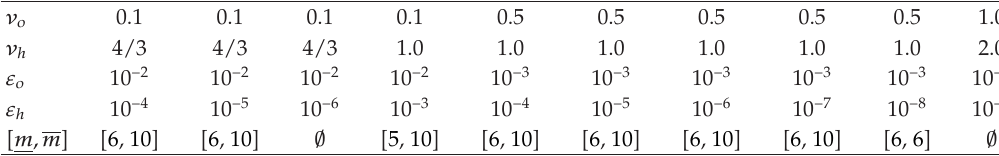
Table 5: Solutions for the problem (cid:3) 4.3 (cid:4) , (cid:3) 4.5 (cid:4) in the case of N (cid:8) 10. ν